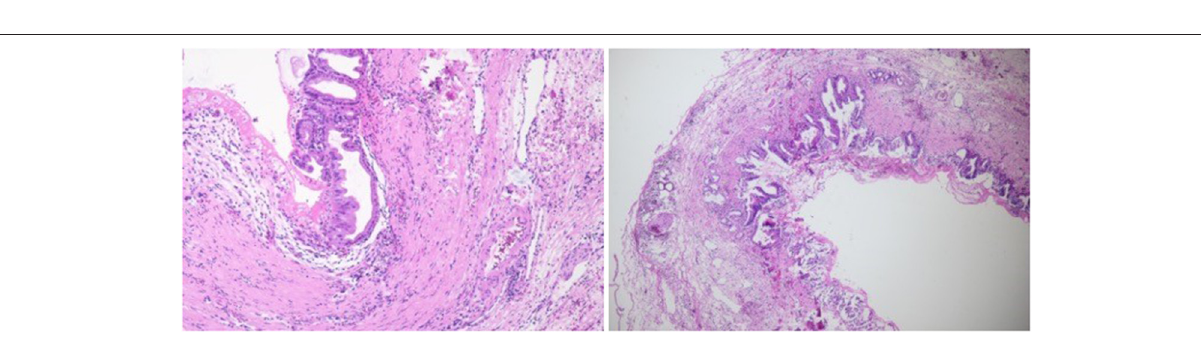
combined with an end-to-side and hepaticojejunostomy, which is recommended for cases with a wide drainage neck or a choledochal cyst coexisting with the CDC (3, 5, 10, 11).